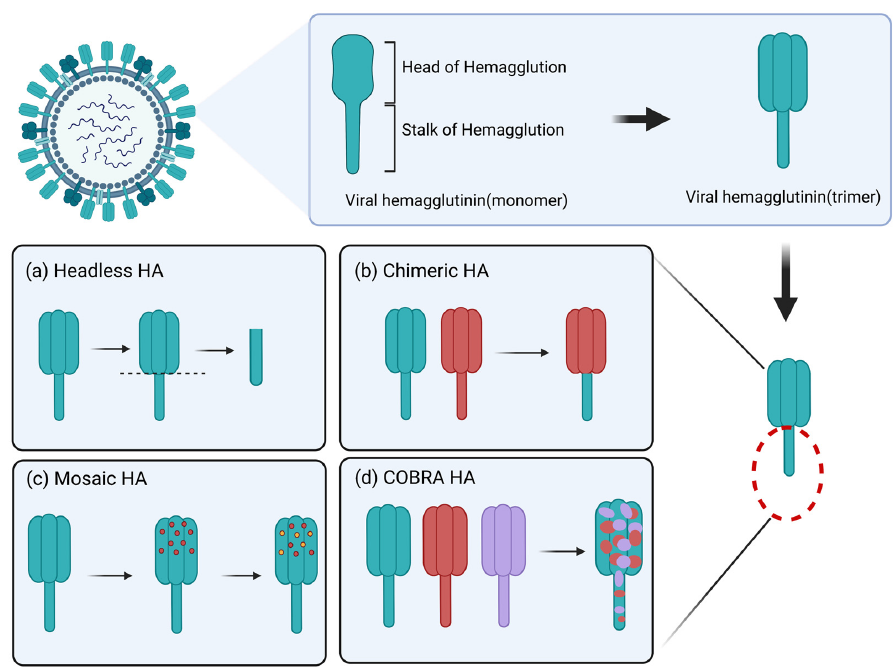
Figure 4. Each HA monomer consists of two parts, a spherical head and a stalk stem, and the three HA monomers are combined in a noncovalent bond to form a homotrimer. There are several strat- egies for the development of HA-based influenza vaccines as follows. ( a ) Complete removal of the HA head region to create a “headless” HA structure, retaining only the conserved HA stem. ( b ) Sequential immunization with chimeric HA vaccines generated using identical HA stalk regions and different HA heads that induced antibody responses are concentrated in the conserved HA stems. ( c ) Replacement of immunodominant antigenic sites in the head with sequences of other HA subtypes. ( d ) COBRA HA vaccines are developed through a series of HA protein comparisons and subsequent generation of shared sequences to optimize HA peptides that elicit a broadly reactive immune response against influenza viruses. Image created with BioRender (https://biorender.com/